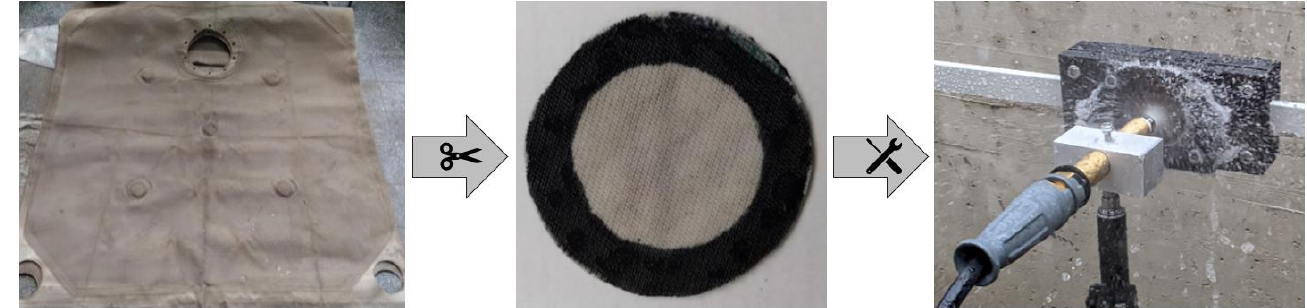
Figure 2. Methodology of permeability test samples preparation including jet cleaning.